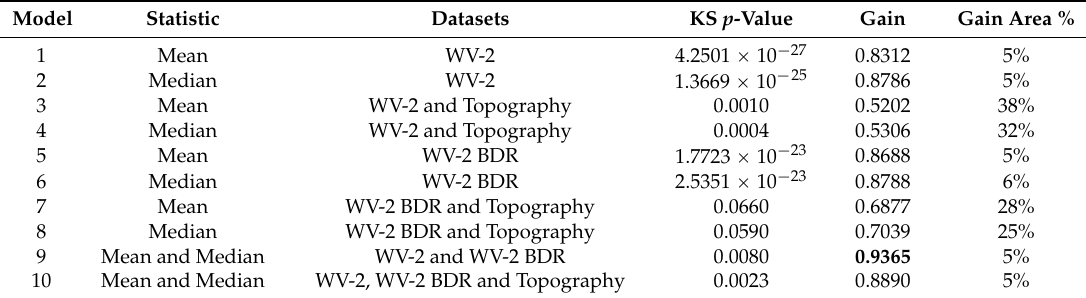
Table 5. Model results.